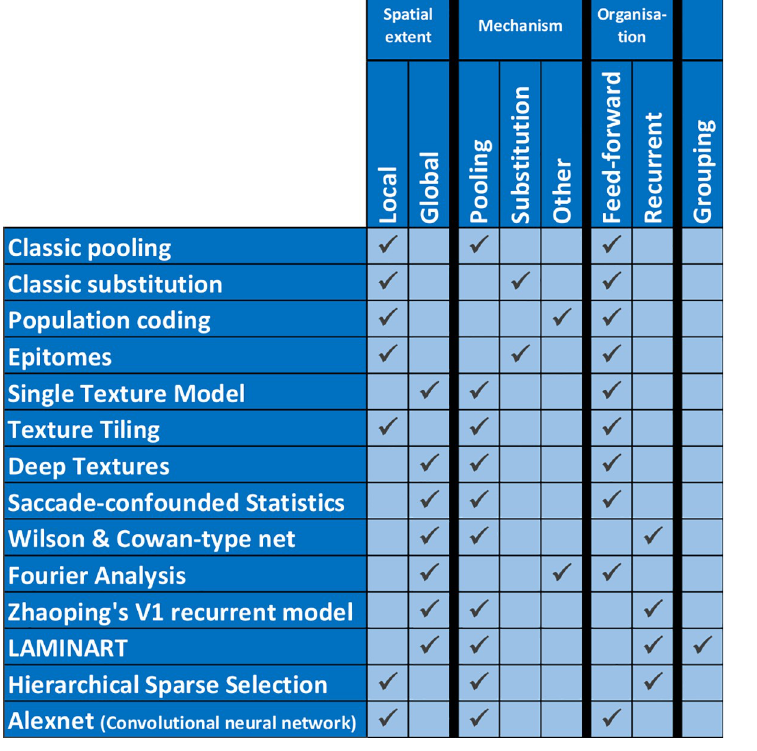
Fig 3. Tested models and their characteristics. Models may integrate information locally or globally, and the interference mechanism may be pooling, substitution, or other. Models are feed-forward or recurrent, and may or may not compute grouping-like aspects of the stimulus. The aim of the current work is to investigate which models can explain the global effects of